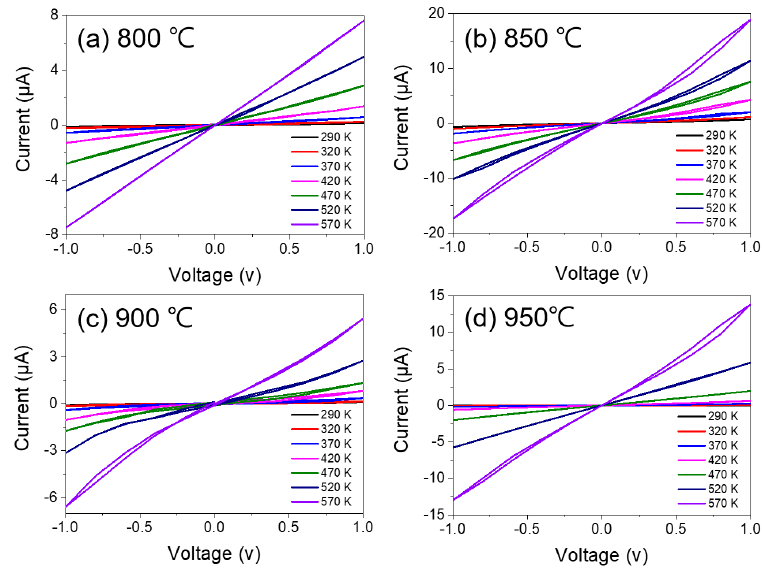
Figure 4. The temperature-dependent I–V characteristics of the Mo x W 1 − x S 2 thin films sulfurized at ( a ) 800, ( b ) 850, ( c ) 900, and ( d ) 950 °C.